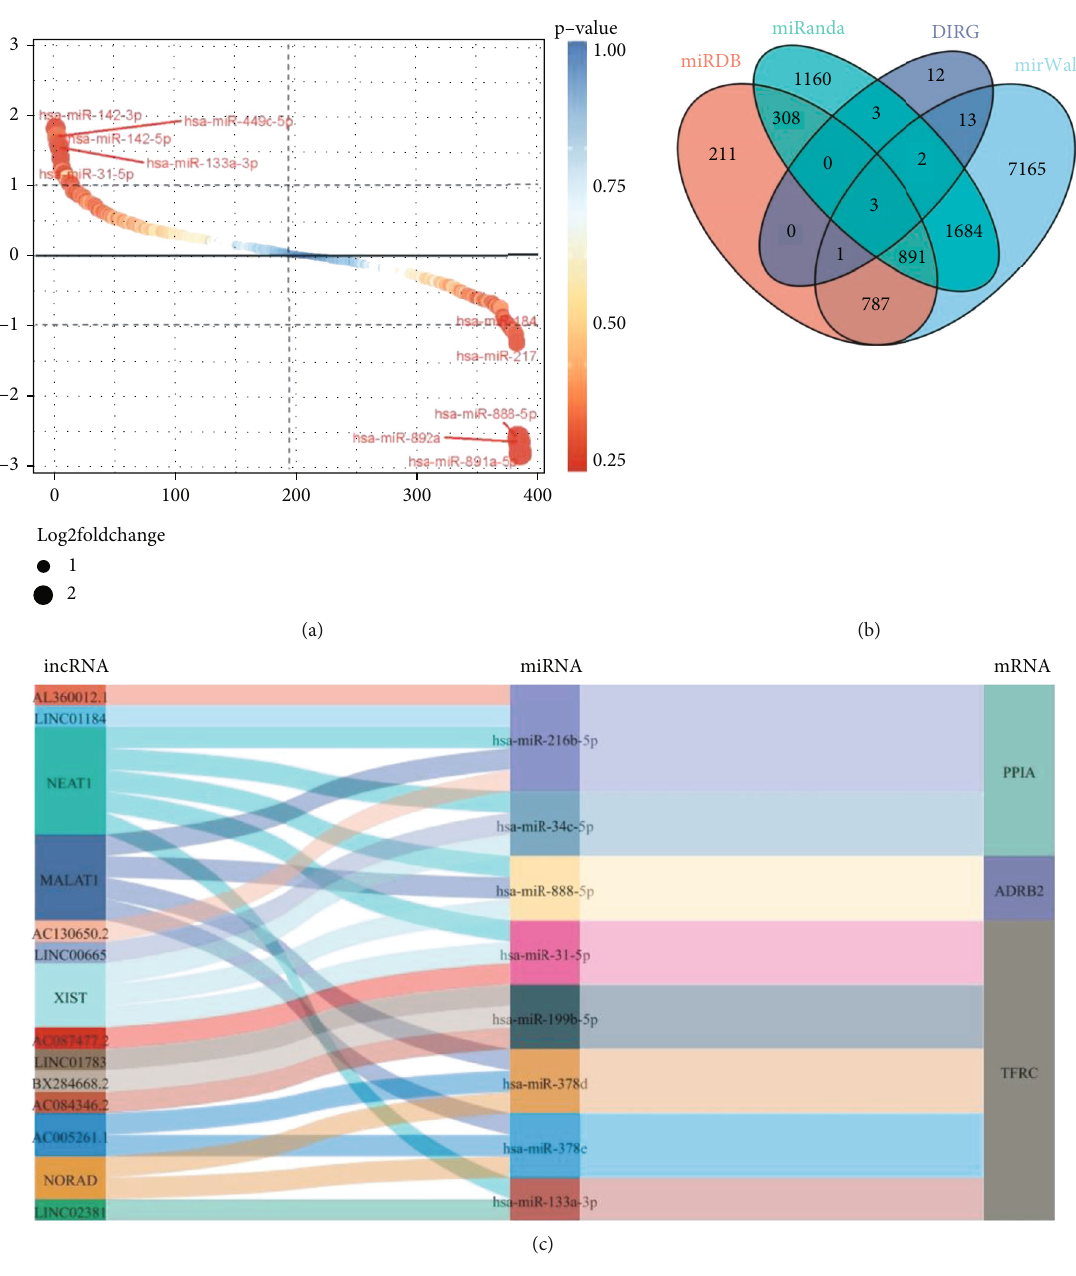
Figure 6: Identi fi cation of ceRNA related to IgAN progression. (a) Gene rank of DE-miRNAs in GSE141344. 10 upregulated and 10 downregulated DE-miRNAs were identi fi ed using the package “ DESq2 ” at P < 0 : 05 and ∣ log DIRGs and the data from miRDB, miWALK, and miRanda databases. There were three common targeted DIRGs (PPIA, ADRB2, and TFRC) in these three databases. (c) ceRNA network related to IgAN progression, including 8 miRNAs, 14 lncRNAs, and 3